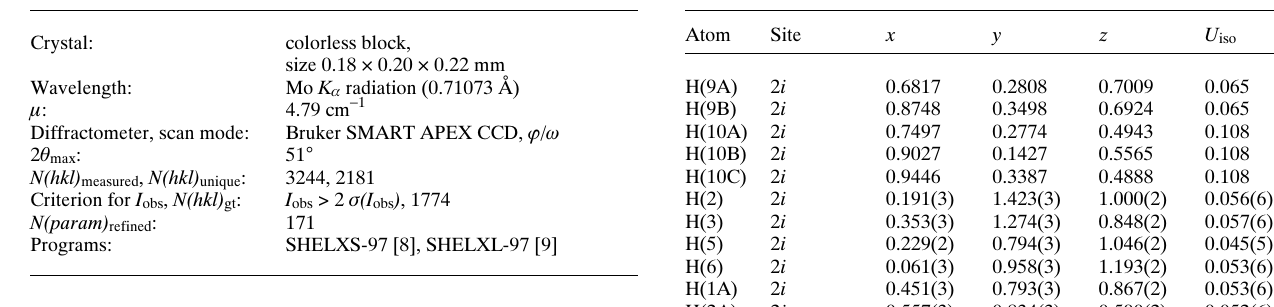
Table 2. Atomic coordinates and displacement parameters (in Å 2 ) . Table 1. Data collection and